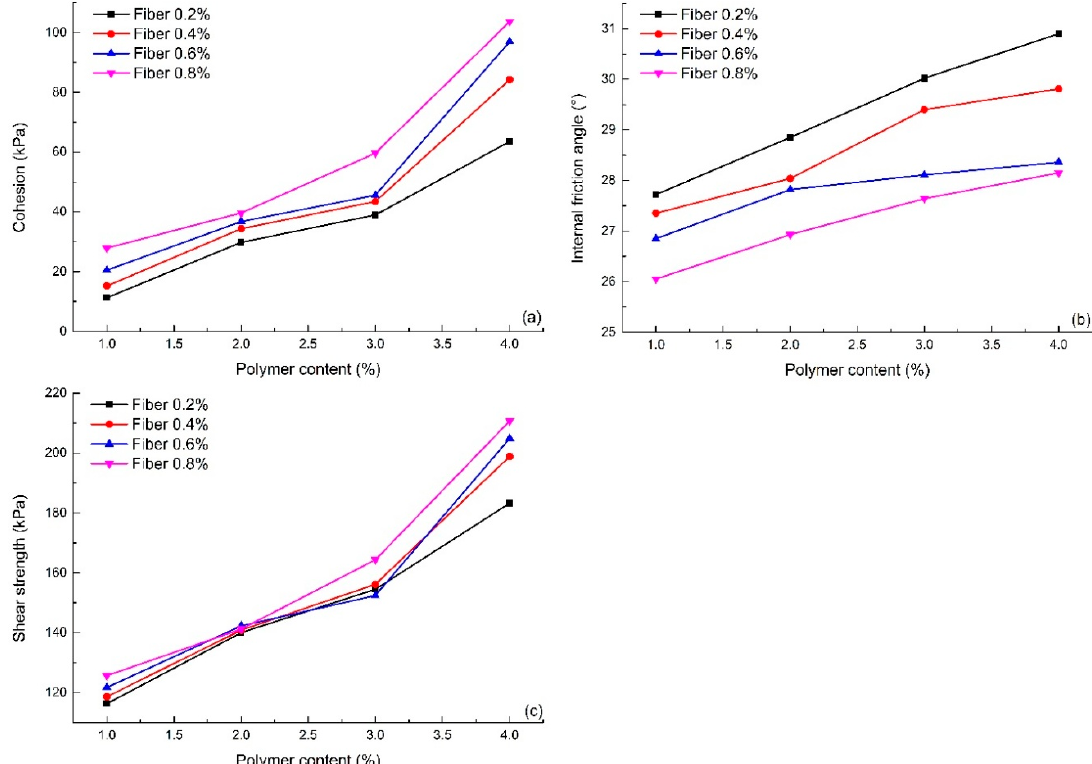
Figure 9. The variation curve with the change of polymer content: ( a ) Cohesion; ( b ) Internal friction angle; ( c ) Shear